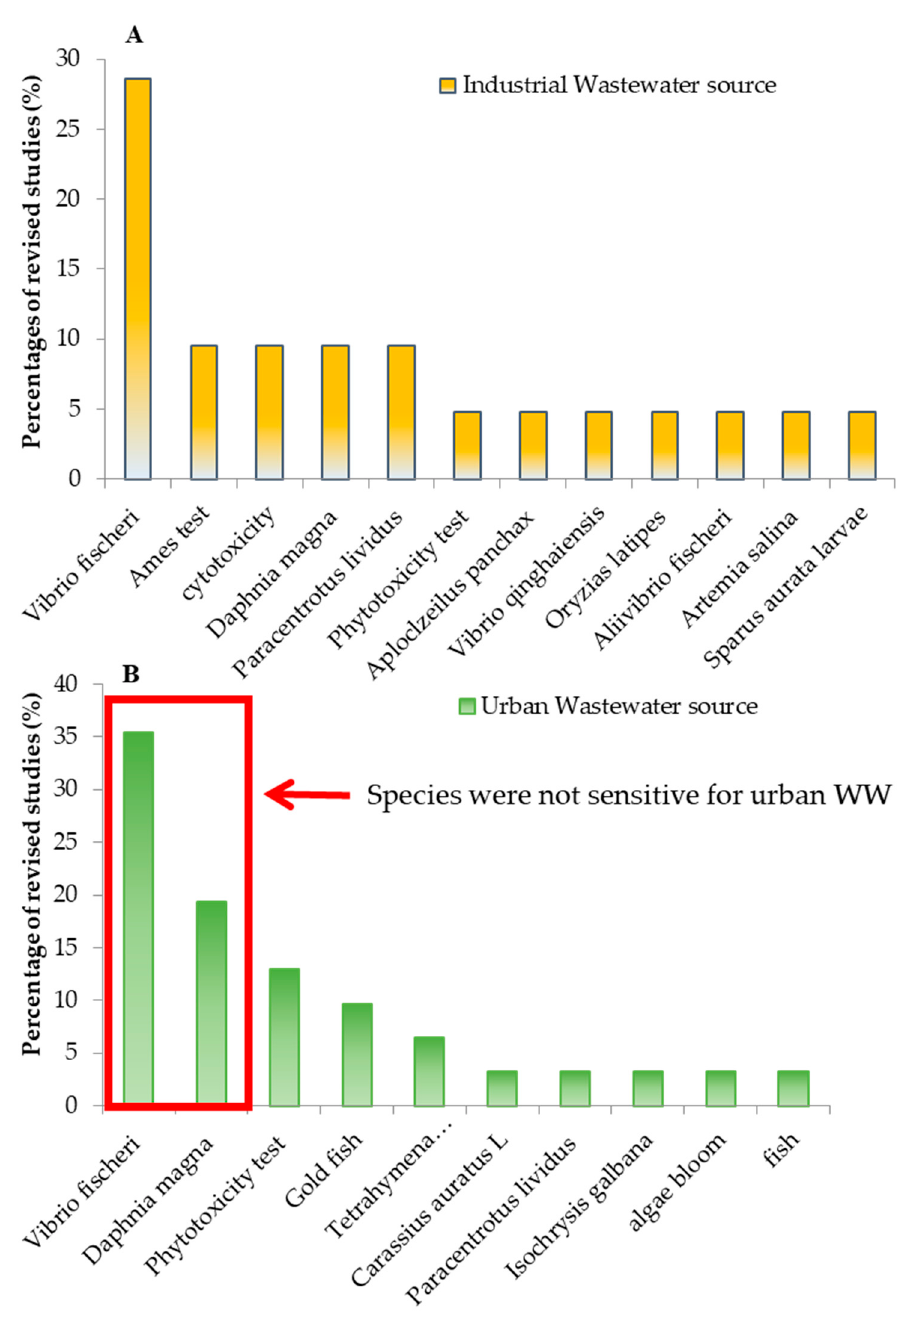
Figure 3. Schematic representation of species used for toxicity assessment in revised studies; A - for industrial wastewater and B - for urban wastewater.